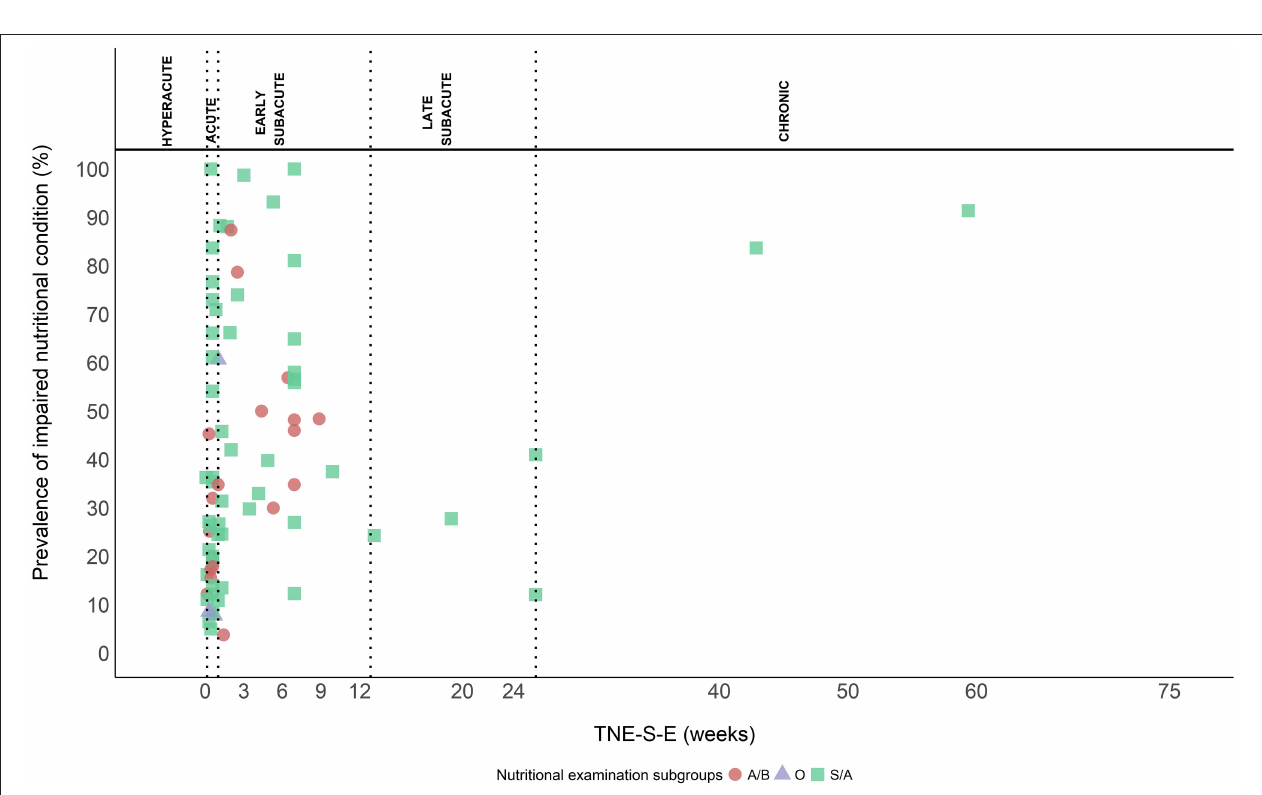
FIGURE 6 | Methods used to examine the prevalence of INC. Screening/assessment tools (S/A) (squares), anthropometrical/biochemical measurements (A/B) (circles), and other (O) (triangles) (combination of S/A tools and A/B measurements).